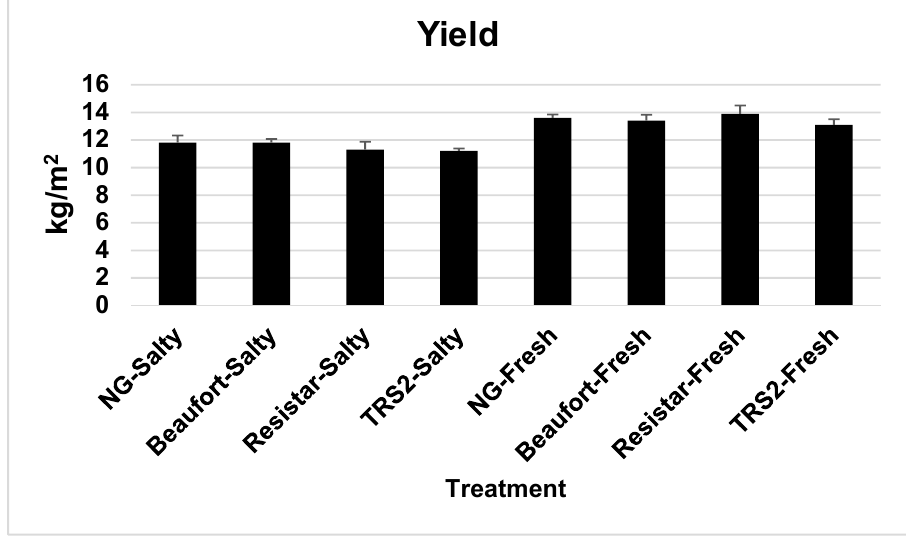
Figure 1. The influence of water quality (salty or fresh) and ‘Lorka’ cherry tomato on ‘Beaufort’, ‘Resistar’ or ‘TRS2’ rootstock on cumulative yield from October through March (NG—non-grafted) (means ± S.E.).